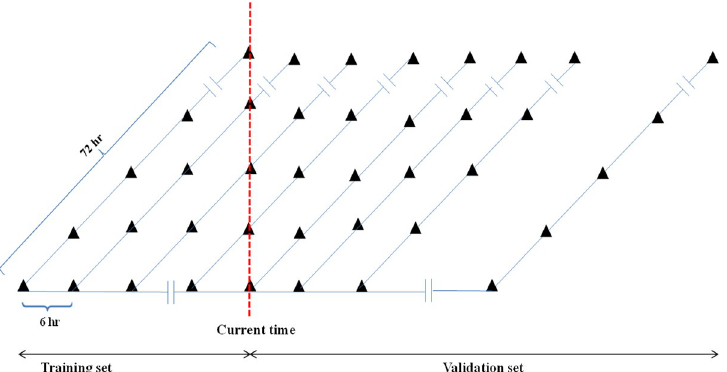
Figure 5. The schematic of the selection of training and validation set data in the real-time forecast of the WRF model output data.